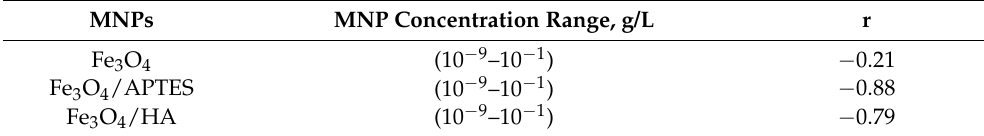
Table 3. Correlation coefficients, r, between dependencies of I rel and ROS rel on MNP